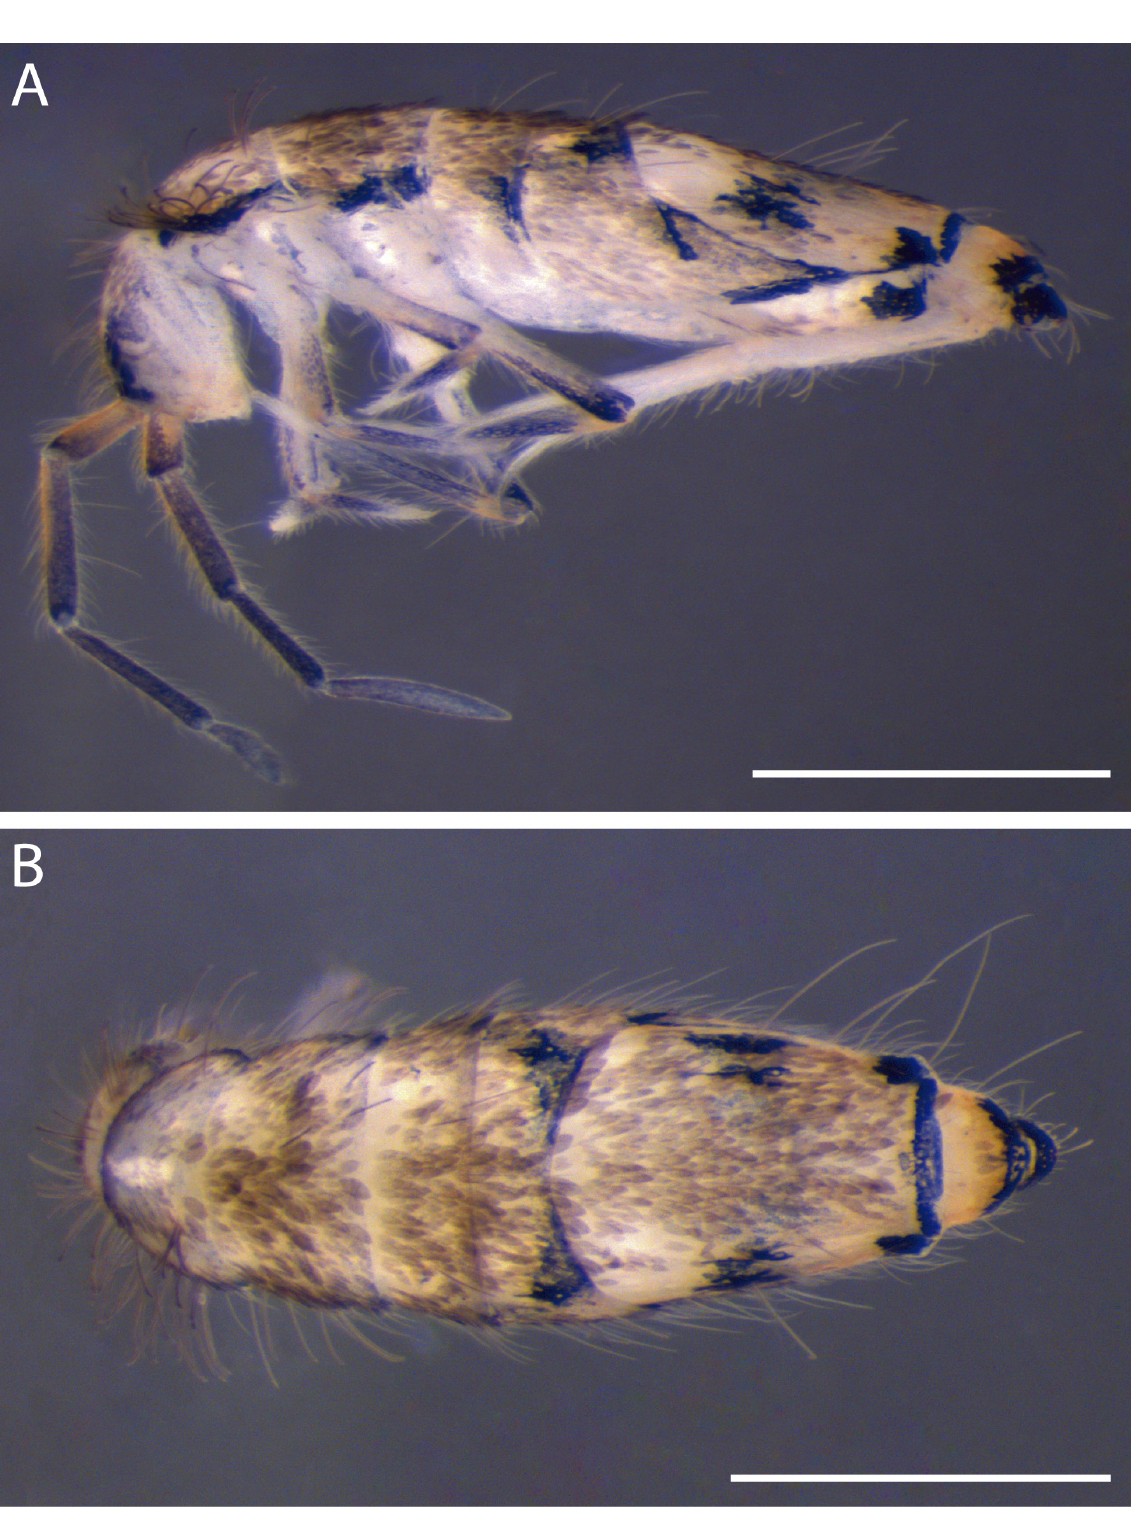
Fig. 8. Willowsia neonigromaculata sp. nov., paratype, ♀ (INHS 810158), habitus. A . Lateral view. B . Dorsal view. Scale bars: 0.5